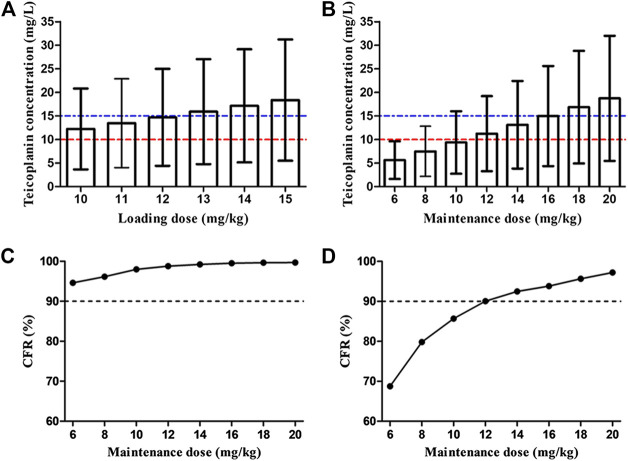
Overall teicoplanin C
min with different loading doses (A) and maintenance doses (B). Each bar represents the mean ± standard deviation. The dashed red line and blue line indicate the targets C
min of 10 mg/L (moderate infection) and 15 mg/L (severe infection), respectively. Cumulative fraction of response (CFR) of different maintenance doses for AUC24/MIC ≥ 125 (C) and 345 (D). AUC24/MIC ≥ 125 and 345 were defined as the target values for moderate and severe infection, respectively. The MIC range and distribution are based on the EUCAST data published in 2019 (https://mic.eucast.org/Eucast2/regShow.jsp?Id=20922). Loading doses were administered every 12 h for three doses and C
min was simulated by day 3 (48 h). Maintenance doses were administered once daily and C
min was simulated by day 5 (96 h).